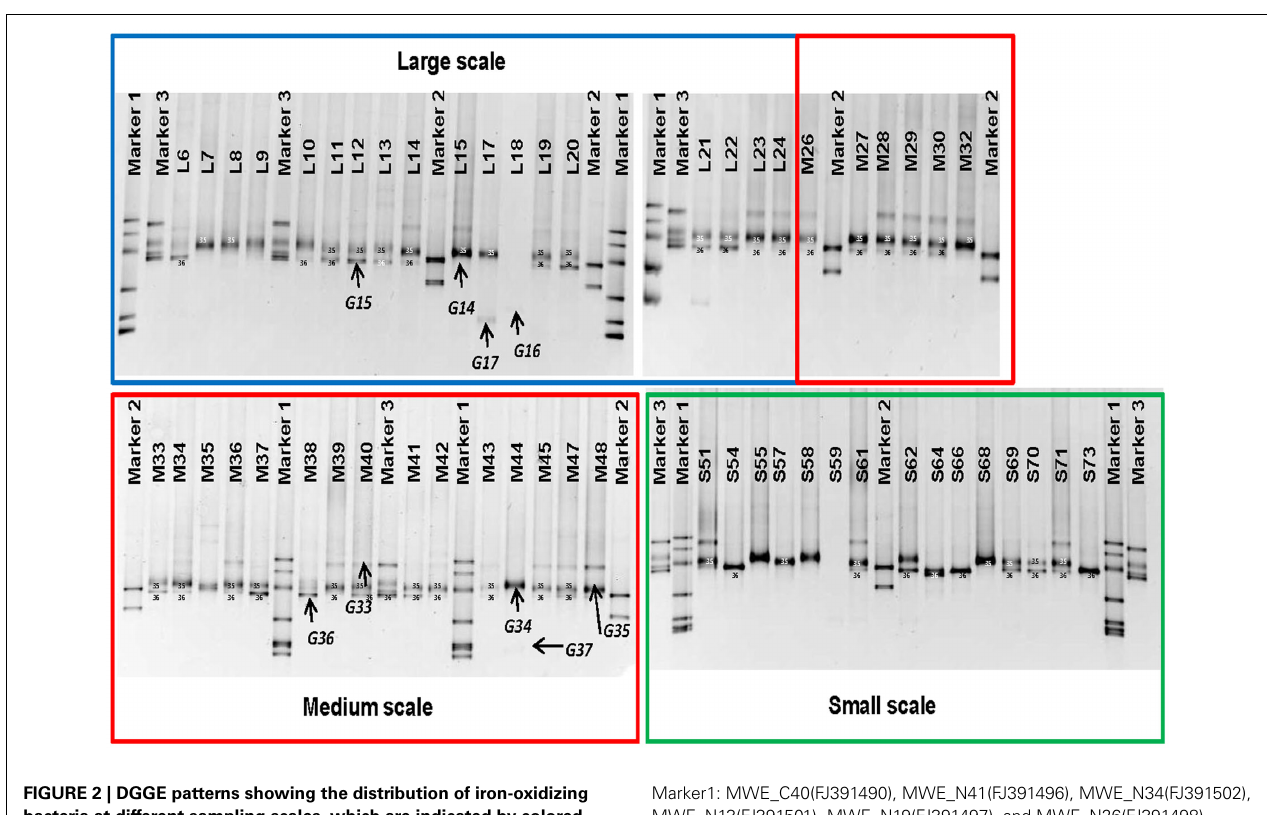
FIGURE 2 | DGGE patterns showing the distribution of iron-oxidizing bacteria at different sampling scales, which are indicated by colored boxes. Bands G14–G17 and G33–G37 were sequenced and shown in Figure 4 . Sequenced clones obtained previously were used as markers.